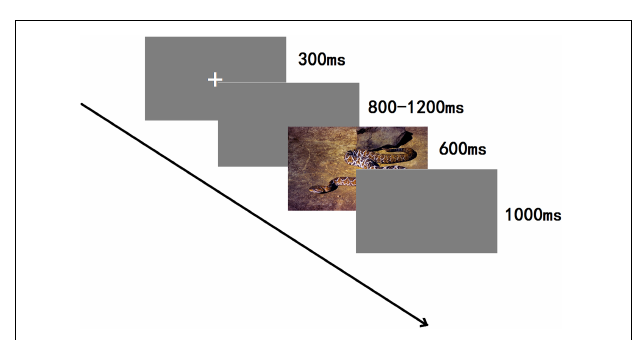
FIGURE 2 | The sequence of events in an experimental